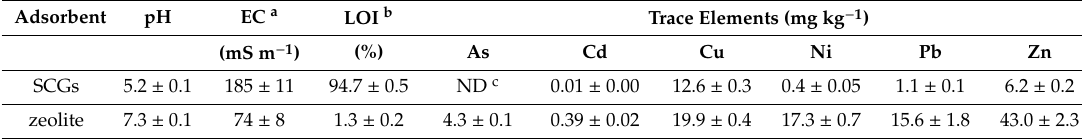
Table 1. Selected physicochemical properties of spent co ff ee ground (SCGs) and zeolite. Adsorbent pH EC